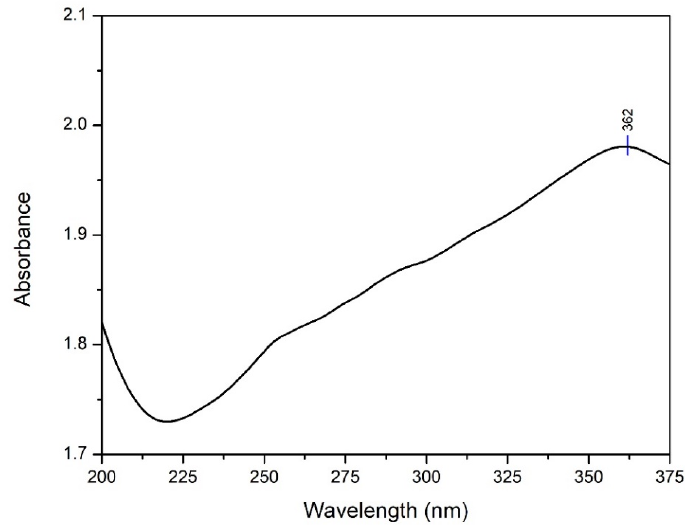
Figure 4. TiO 2 nanoparticle absorption spectrum.